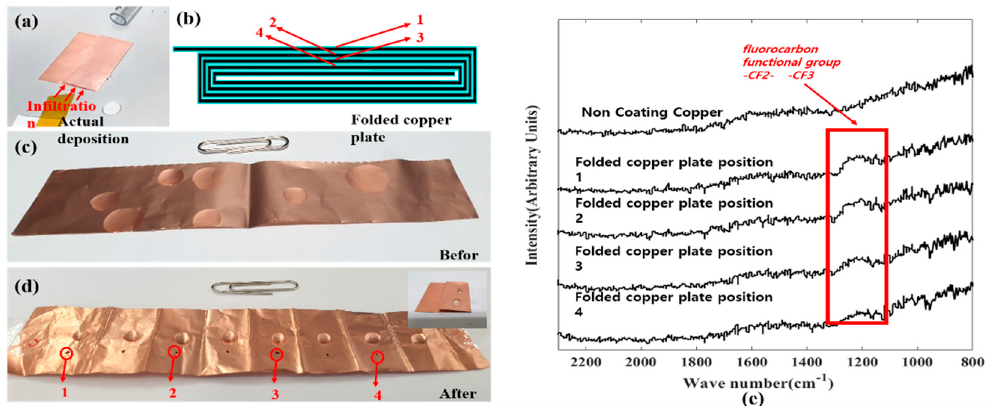
Figure 4. ( a ) A manifolded copper sheet in the iCVD reactor; ( b ) schematic of the folded copper sheet and FT-IR Spectrometer measurement locations; ( c ) water droplets on bare copper sheet; ( d ) water droplets on unfolded copper sheet after coating; and ( e ) FT-IR analysis before and after coating.